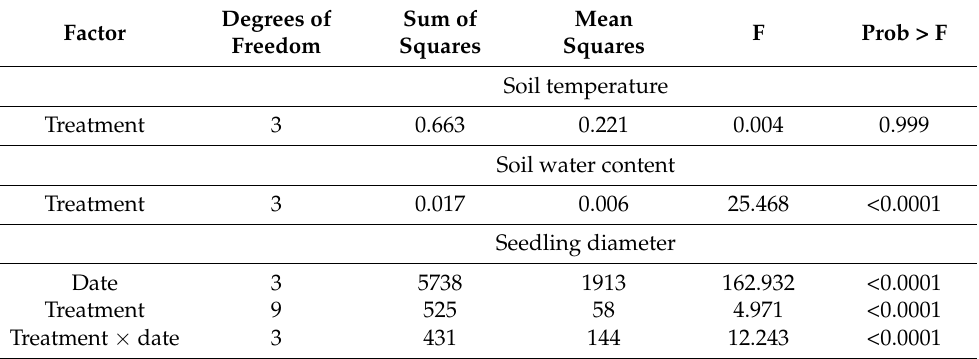
Table 2. Results of ANOVA applied to soil temperature and water content, diameter, height, length of aerial part and of roots, and dry weight of aerial part and of roots among post-fire treatments in Sierra de Los Donceles forest (Li é tor, Castilla La Mancha, Spain). Degrees of Sum of Mean Factor F Freedom Squares Squares Soil temperature Treatment